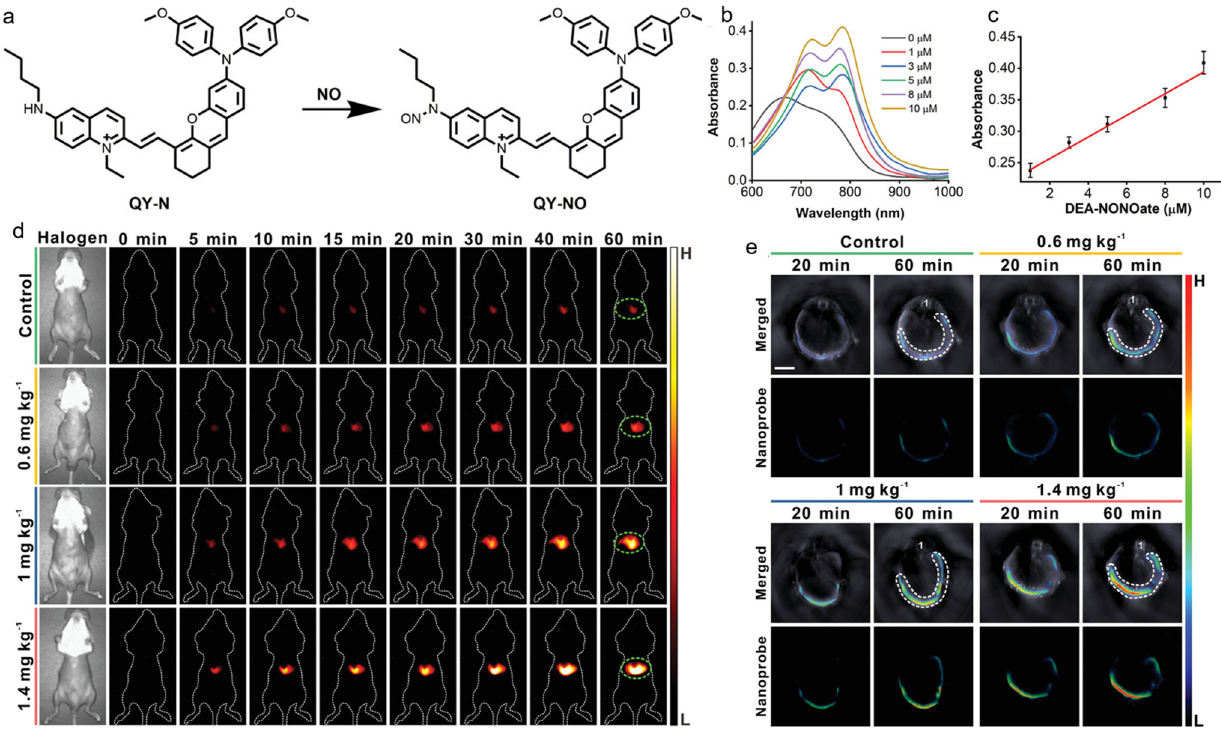
Figure 14. ( a ) The response of QY-N towards NO; ( b ) absorption spectra and ( c ) intensity at 780 nm of QY-N with the treatment of different concentrations of DEA·NONOate; ( d ) NIR-II fluorescence and ( e ) PA imaging of liver injury mice intravenously injected with the nanoprobe QY-N at different time points. (Reproduced with the permission from ref. [164]. Copyright 2021, Wiley-VCH GmbH).